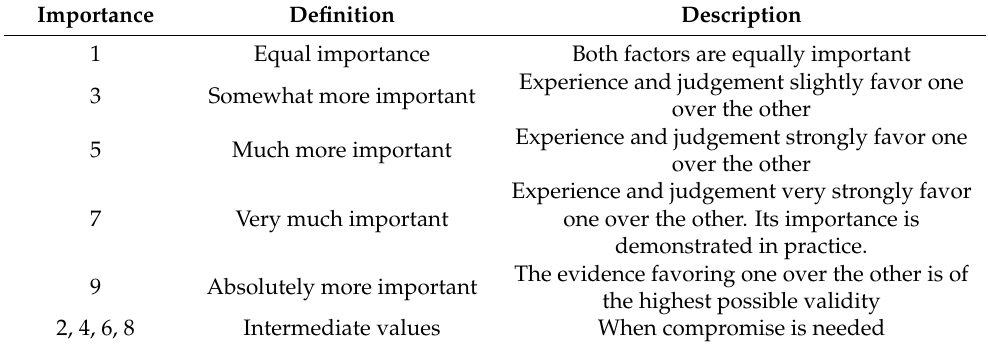
Table 3. The common scale of